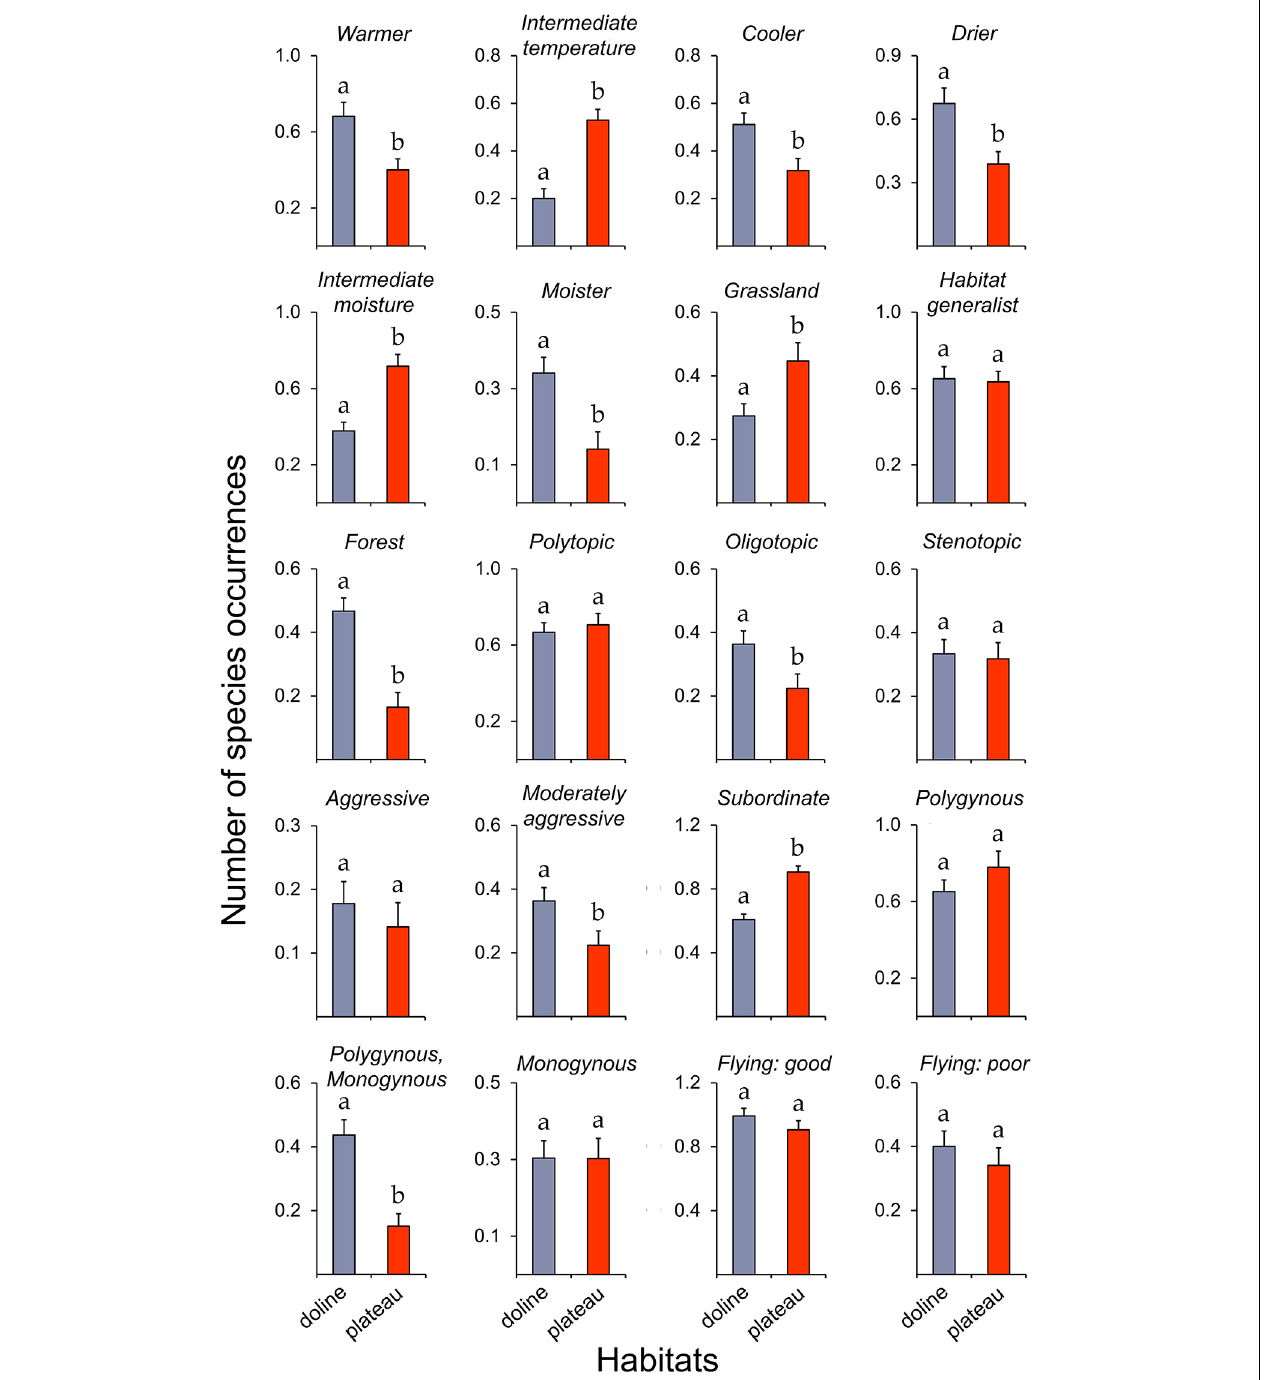
FIGURE 2 | Occurrences of the different functional groups and traits (see Table 1 ) of ant species (mean ± SE) between dolines and the plateau. Different lowercase letters indicate significant differences between the two habitats (see Table 2 ).